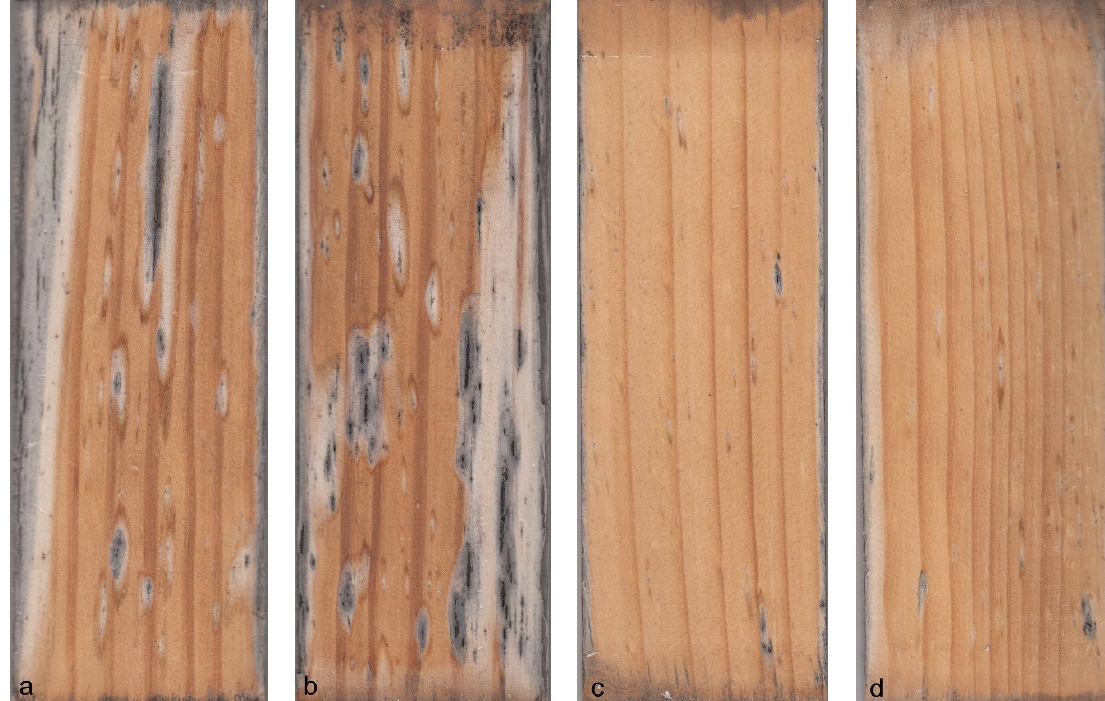
Figure 10. Effect of pre-treating radiata pine with a combination of a UV absorber and a hindered amine light stabilizer (HALS) on the performance of a durable acrylic coating: ( a,b ) Untreated controls exposed to the weather for 28 months in Canberra, Australia. Note darkening of wood beneath the coating and failure of the coating; ( c ) Panel pre-treated with a UVA and low molecular weight HALS; ( d ) Panel pre-treated with a UVA and an oligomeric HALS (panels are 23 cm × 8 cm in size, length ×